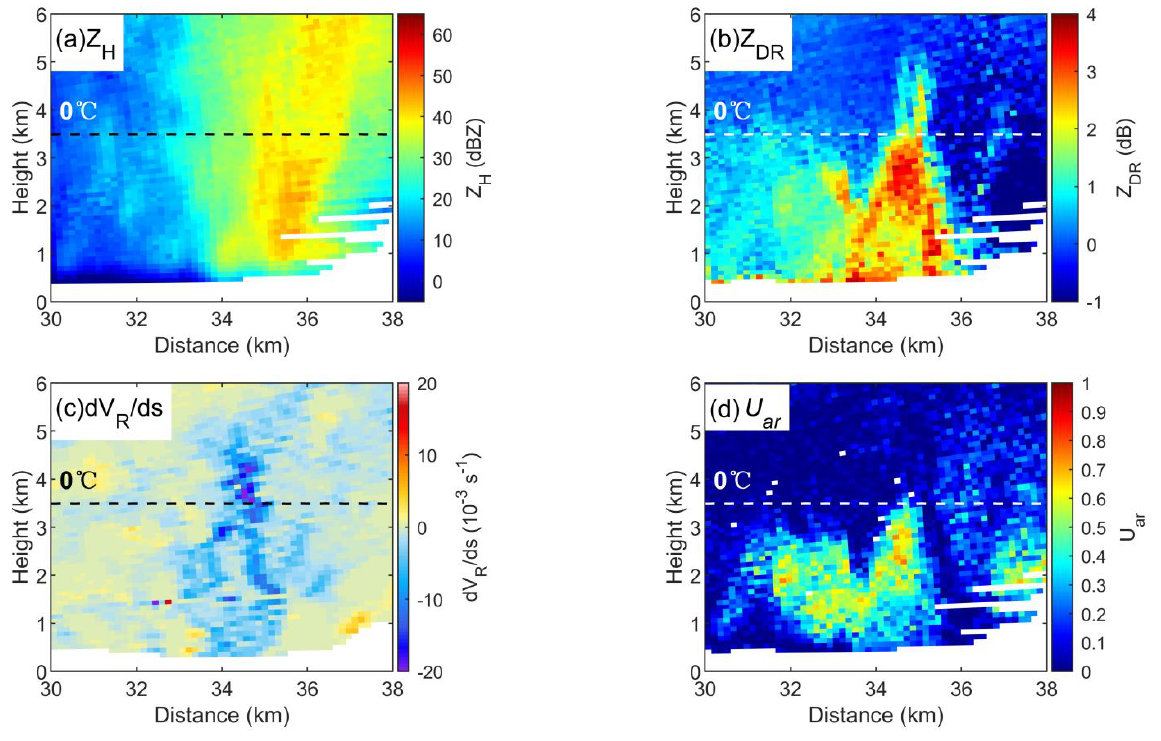
Figure 12. Variables in area B with the Z DR column. ( a ) Z H , ( b ) Z DR , ( c ) dV R /ds, ( d ) U ar .